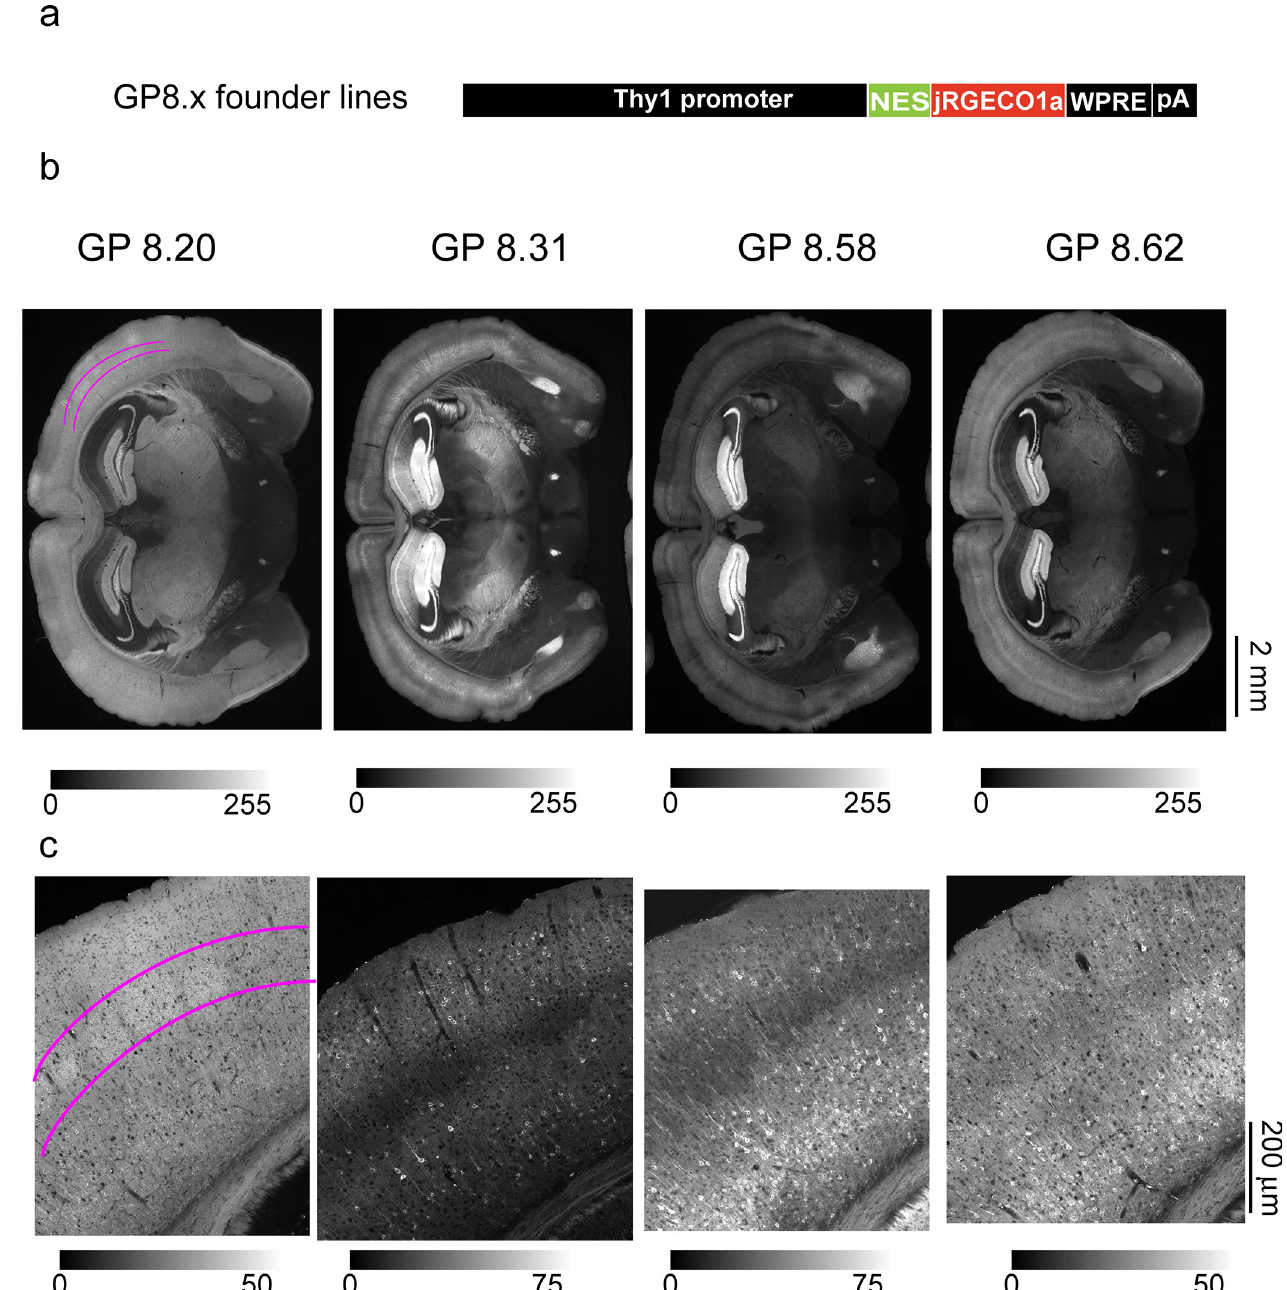
Fig 1. Expression of jRGECO1a in Thy1 -jRGECO1a mouse lines. a . Schematic of the transgene cassette used to generate GP8.x lines. b . Fluorescence widefield images of coronal sections from four transgenic lines showing jRGECO1a fluorescence. Magenta marks on the GP8.20 image indicate the location of labeled layer 4 cells (see also S2 Fig). c . Representative confocal images (tiled and stitched to show larger field of view) from the somatosensory cortex of the same lines as in b . https://doi.org/10.1371/journal.pone.0205444.g001 Fig). Expression was detected in multiple other brain regions (Table 1; S1 Data). For example, expression was high in the amygdala in several transgenic lines (Table 1). NeuN immunostaining was used to detect all neurons [30] and thus estimate the propor- tion of jRGECO1a-positive neurons in several brain regions for lines GP8.20, GP8.31, GP8.58,